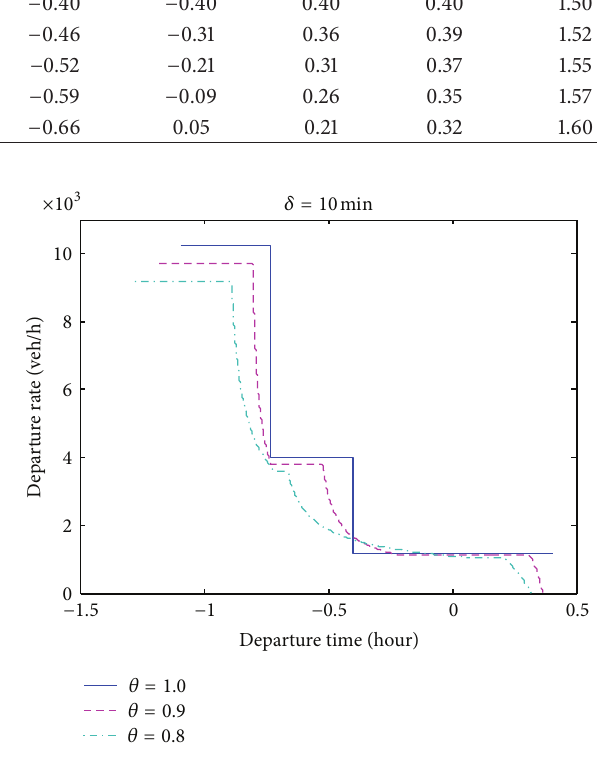
Figure 4: The influence of parameter 𝜃 on departure